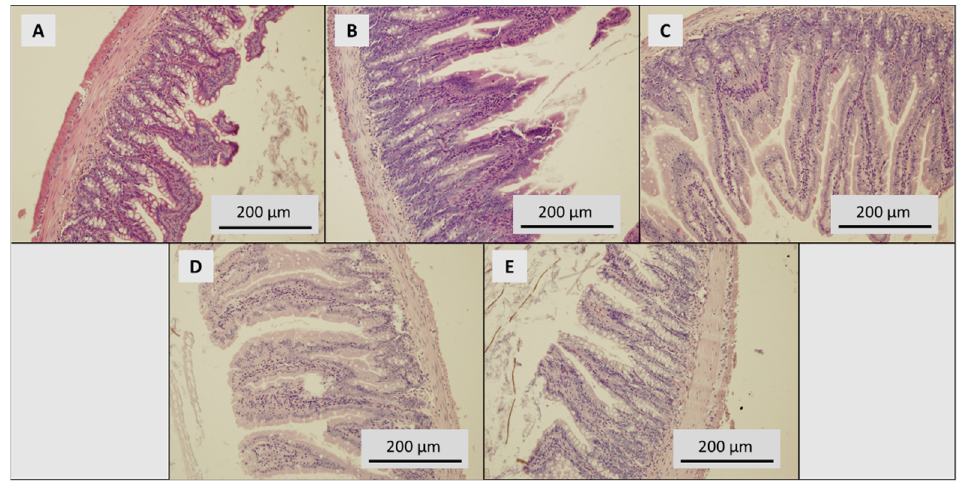
Figure 6. Histological examination of intestine. ( A ) Control group, dose of SeNPs: ( B ) 0.5, ( C ) 1.5, ( D ) 3.0 and ( E ) 5 mg/kg/diet.